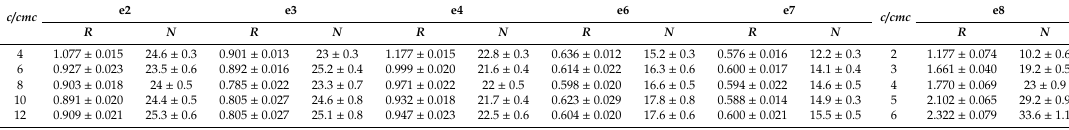
Figure 3. Micelle aggregation number N of plotted as a function of concentration c/cmc for spacer values s of diester gemini surfactants e(s) . The solid curves are a guide to the eye. Table 3. A : Values of fitting parameter R , micelle aggregation number N of diester gemini surfactants e(s), s = 2 to 7, at the concentrations 4 × cmc to 12 × cmc , and surfactant e8 at the concentrations 2 × cmc to 6 × cmc as determined from time-resolved fluorescence quenching